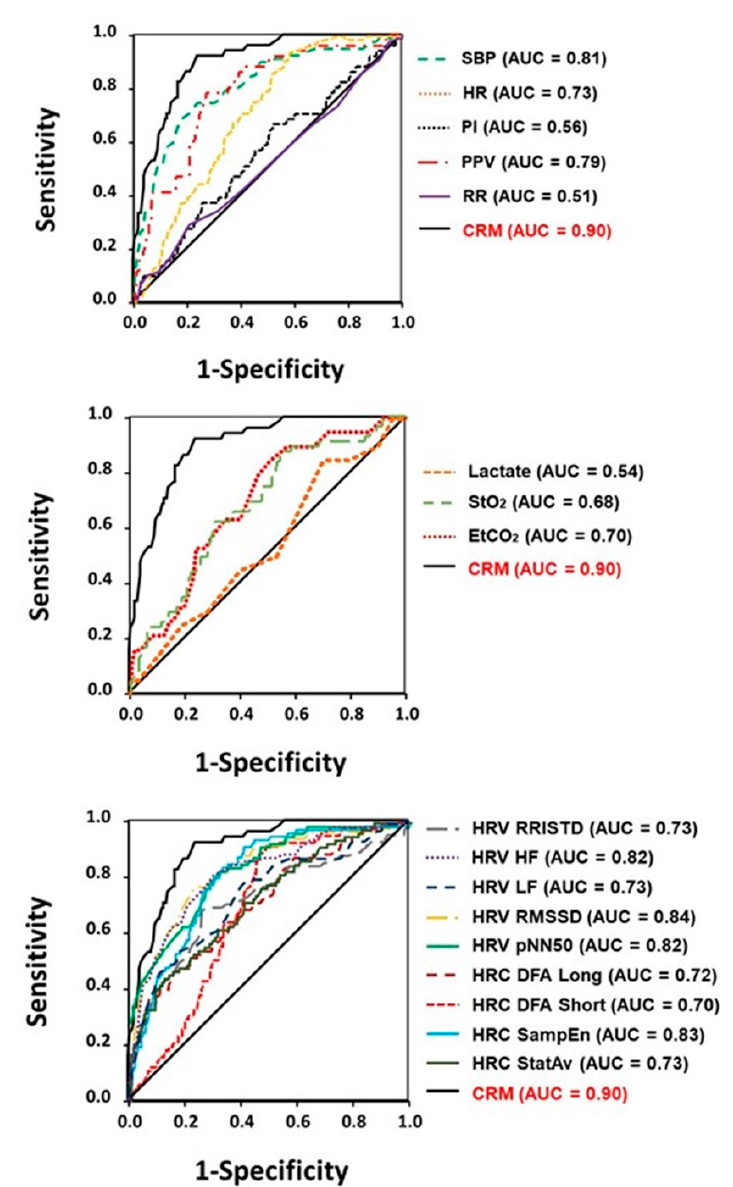
Figure 4. ROC AUC comparisons for prediction of onset of decompensated shock between measures of compensatory reserve (CRM) and standard vital signs ( top panel), metabolic metrics ( middle panel), and autonomic nervous system responses measured by indices of heart rate variability (HRV) and complexity (HRC) ( bottom panel). SBP, systolic blood pressure; HR, heart rate; PI, perfusion index; PPV, pulse pressure variability; RR, respiratory rate; StO 2 , tissue oxygen saturation; EtCO 2 , end-tidal carbon dioxide; RRISD, R-to-R interval standard deviation; HF, high frequency; LF, low frequency; RMSSD, root mean square standard deviation; pNN50, percentage of RRI that vary by at least 50 ms; DFA detrended fluctuation analysis; SampEn, sample entropy; StatAv, stationarity.